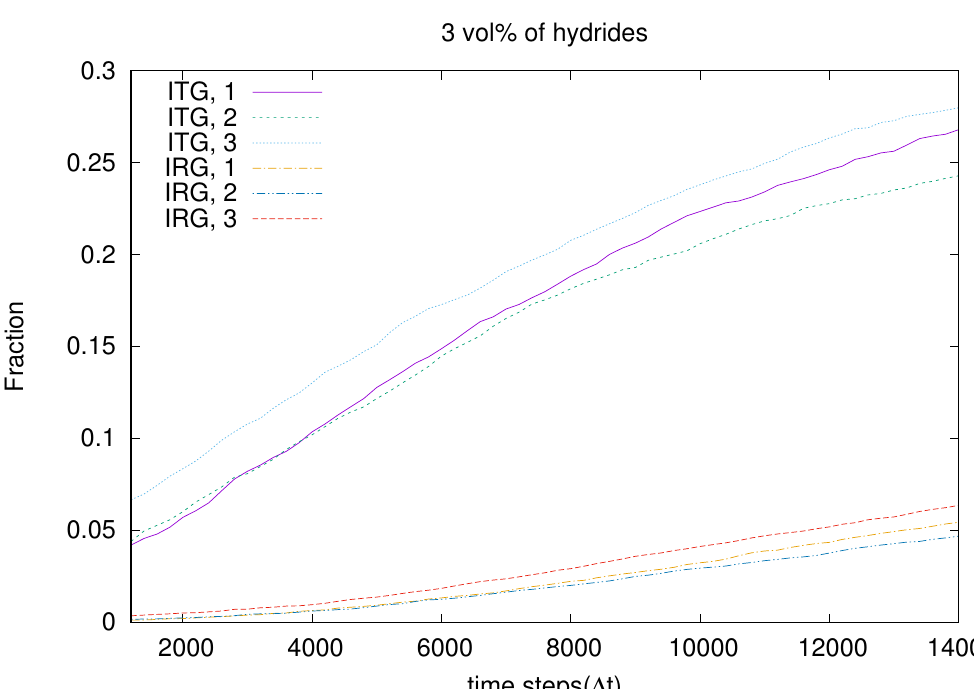
Figure 5. Plot of fractions of intra-granular and inter-granular hydrides with respect to time in the presence of 3 vol% hydrides. The fractions of hydrides with 1, 2 and 3 structural variants cases are plotted. ITG and IRG stand for Inter-granular, Intra-granular, respectively and the numbers next to comma indicate the number of structural variants.